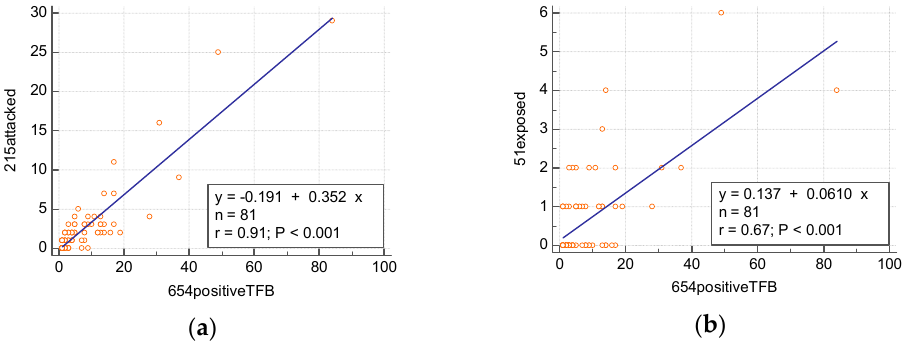
Figure 1. ( a ) Scatter diagram and regression line for regression of the number of 654 positive Taiwan Ferret badger rabies on the number of 215 rabid TFBs involved with human activities, r = 0.91. ( b ) Scatter diagram and regression line for regression of the number of 654 positive TFB rabies on the number of 51 cases exposed to rabid TFBs, r = 0.67. Data were collected from March 2010 to April 2018.